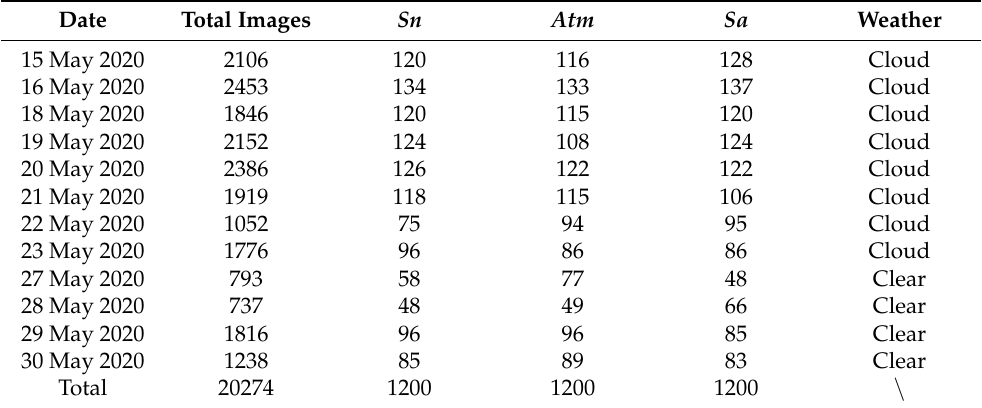
Table 1. Summary of the